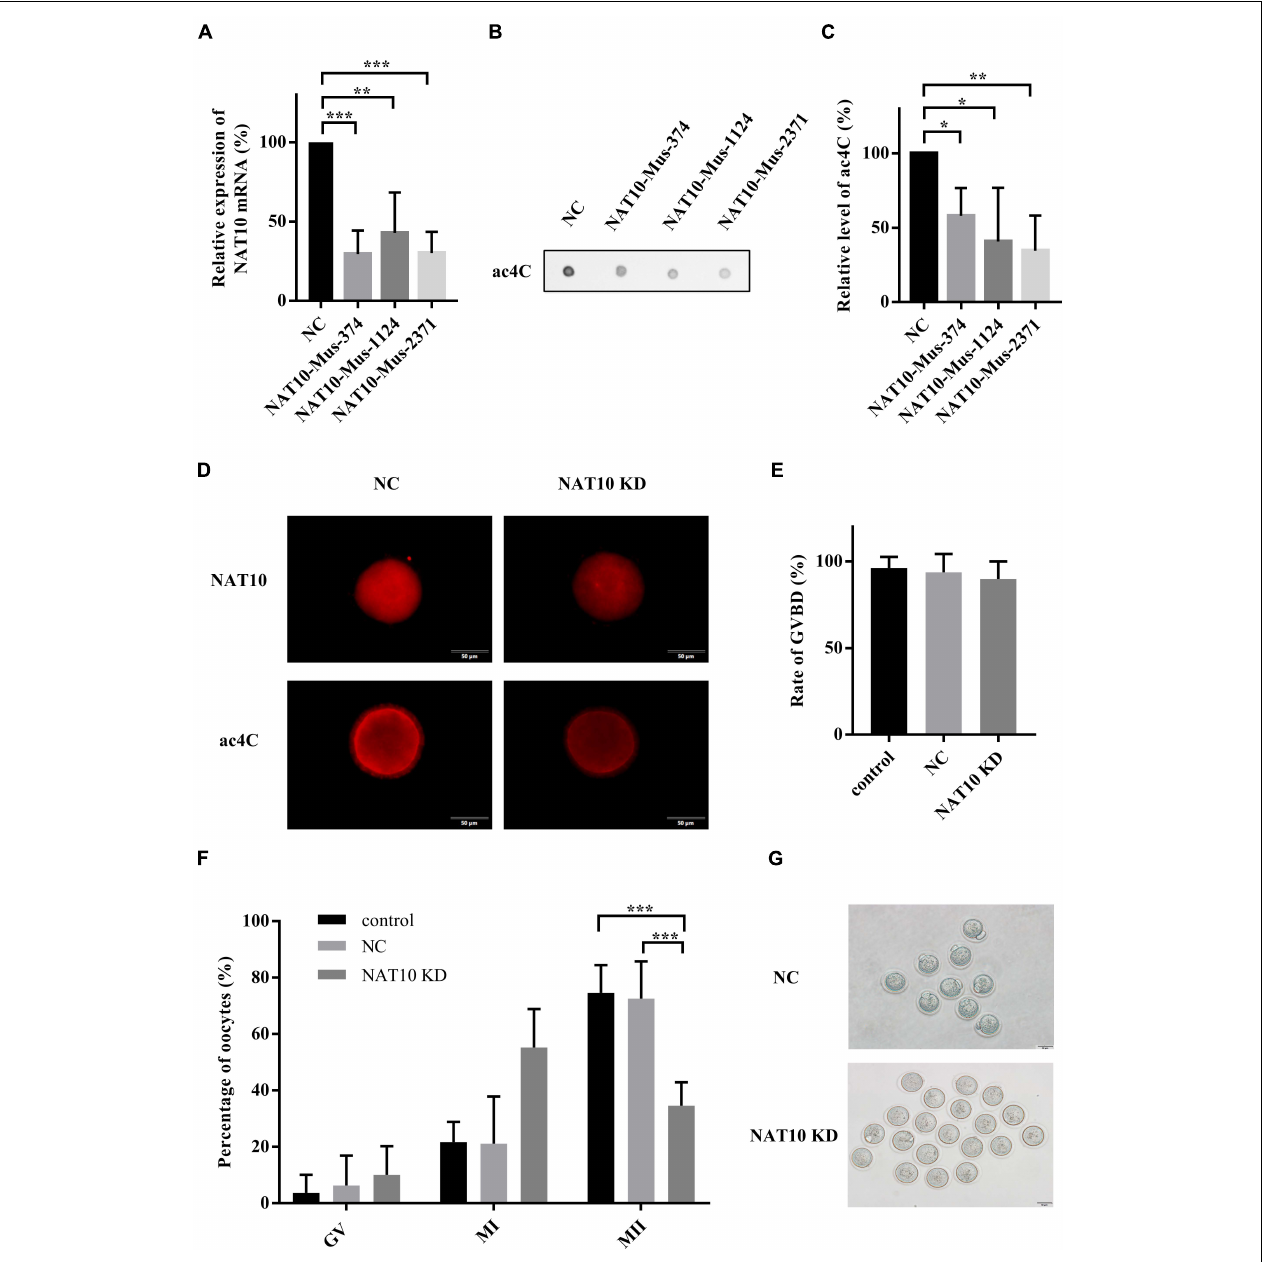
FIGURE 2 | NAT10 knockdown retarded meiotic progression in mouse oocytes. (A) Relative expression of NAT10 mRNA with NAT10 knockdown in TM3 cells. (B,C) ac4C was downregulated by NAT10 depletion in TM3 cells. (D) Representative images of NAT10 and ac4C immunostaining in NC and NAT10 KD oocytes. Scale bar=50 µ m. (E) Quantitative analysis of the GVBD rates in control, NC and NAT10-knockdown oocytes. (F) Percentages of oocytes at different stages after in vitro culture. (G) Phase-contrast images of NC and NAT10 KD oocytes. Scale bar=50 µ m. The data were presented as the mean ± SD from at least three independent experiments. NC, negative control siRNA. NAT10 KD, NAT10 knockdown by siRNA (NAT10-Mus-2371). Control, oocytes without transfection. GVBD, germinal vesicle breakdown. *Significant difference at p < 0.05, ** at p < 0.01, and *** at p < 0.001.